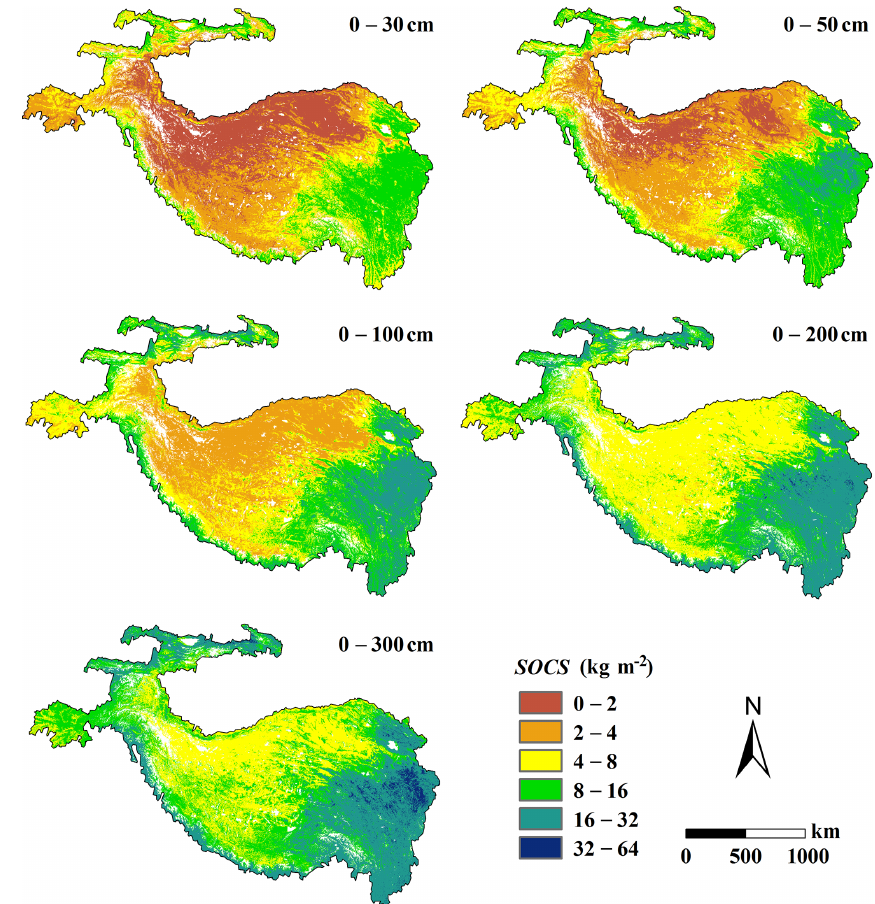
Figure 7. Spatial distribution of SOCS at different depth intervals over the Third